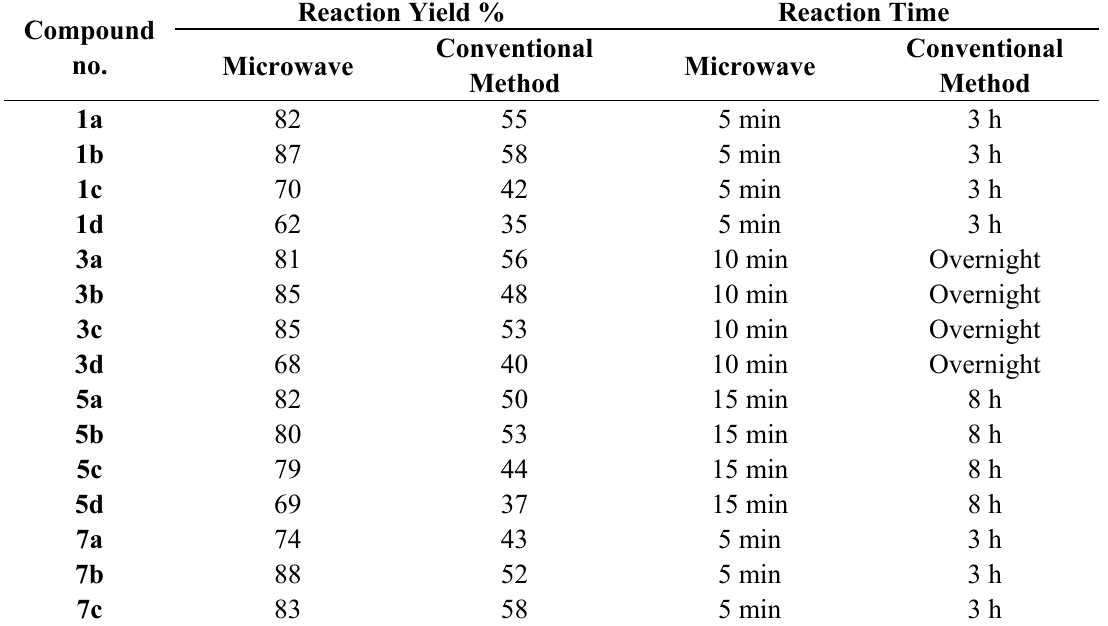
Table 1. Comparison between traditional methods and microwave assisted methods of synthesis of compounds 1a – d , 3a – d , 5a – d , and 7a – c